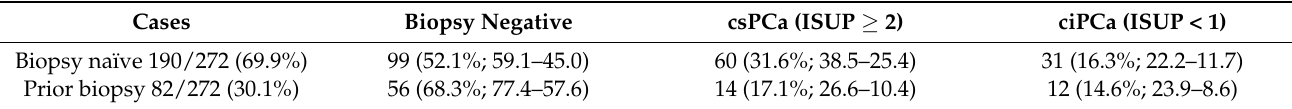
Table 2. Overall cancer detection rate in naïve and prior biopsy cases. For each diagnosis, the number of cases and, in brackets, the percentage and 95% confidence interval are reported.